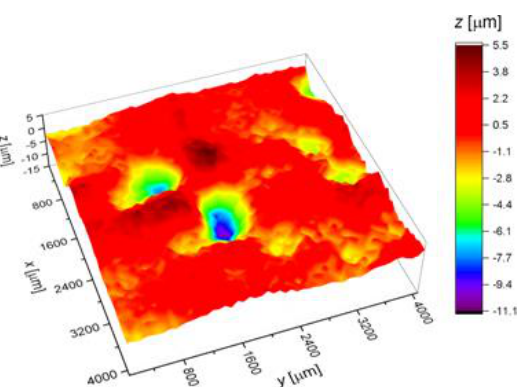
Figure 14. Topography map determined for the AISI 1010 carbon steel after the experiment in sulfolane at 95 C and etching.